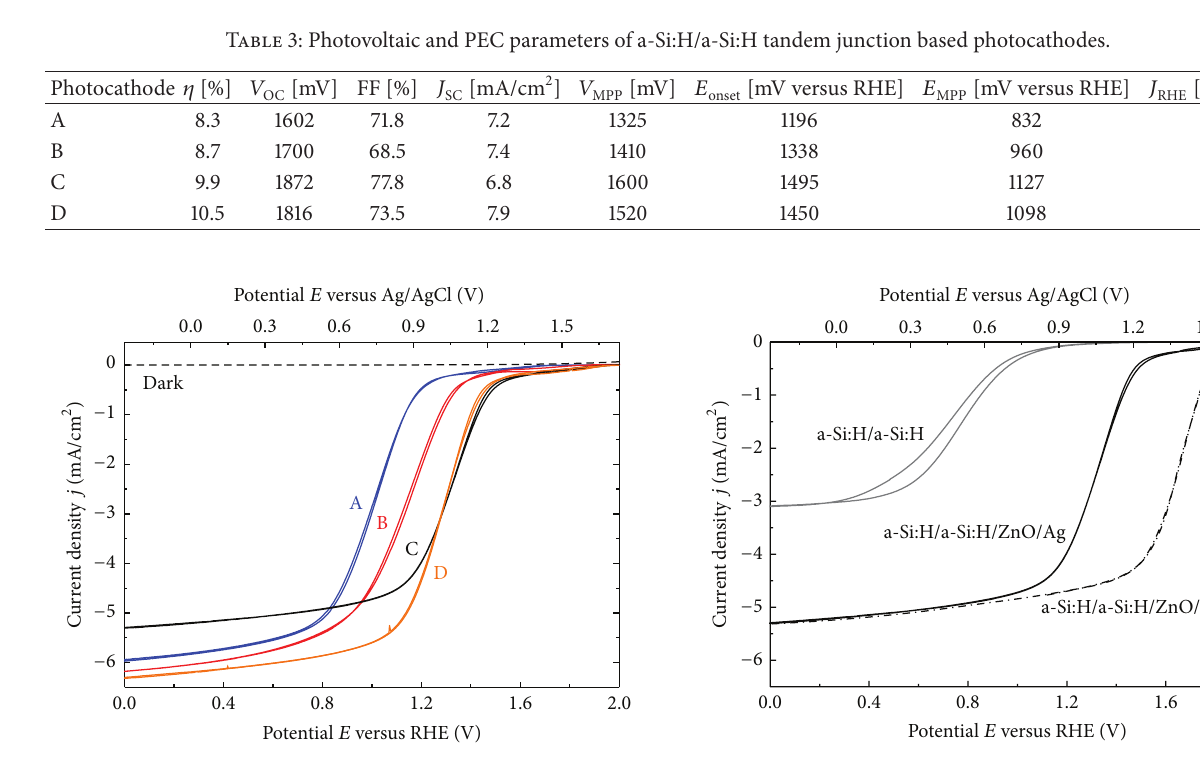
Figure9:Cyclicvoltammetrymeasurementofa-Si:H/a-Si:Hphoto- cathodes (listed in Table 3). Measurements were performed in 0.1M H 2 SO 4 solution (pH 1) under 100mW/cm 2 illumination intensity at a scan rate of 30 mVs −1 . The dark current is shown as a black dashed curve.